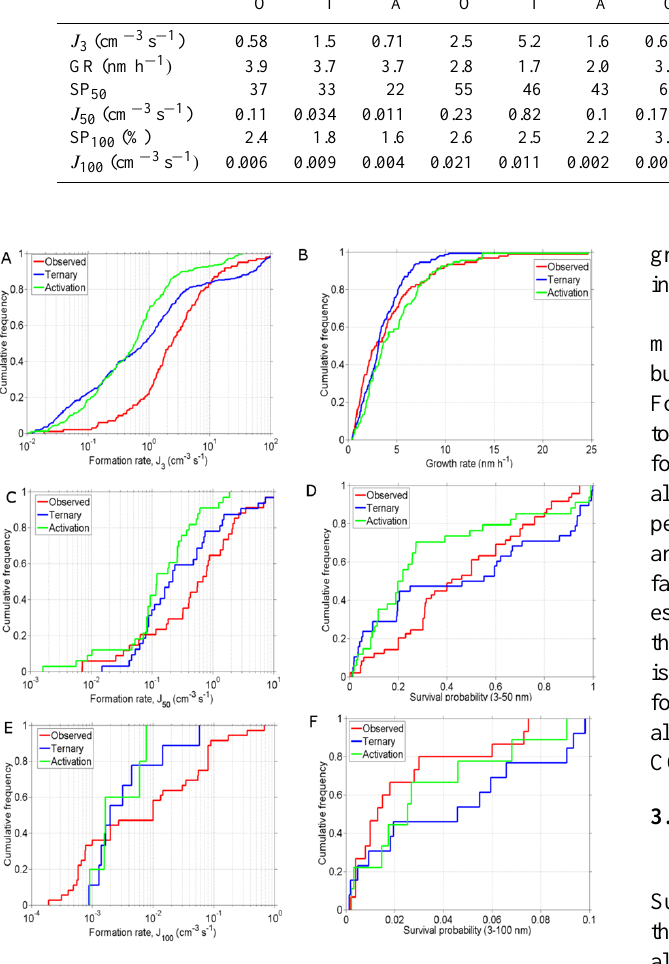
Fig. 8. Same as in Fig. 5, for modeled and measured nucleation metrics at St. Louis